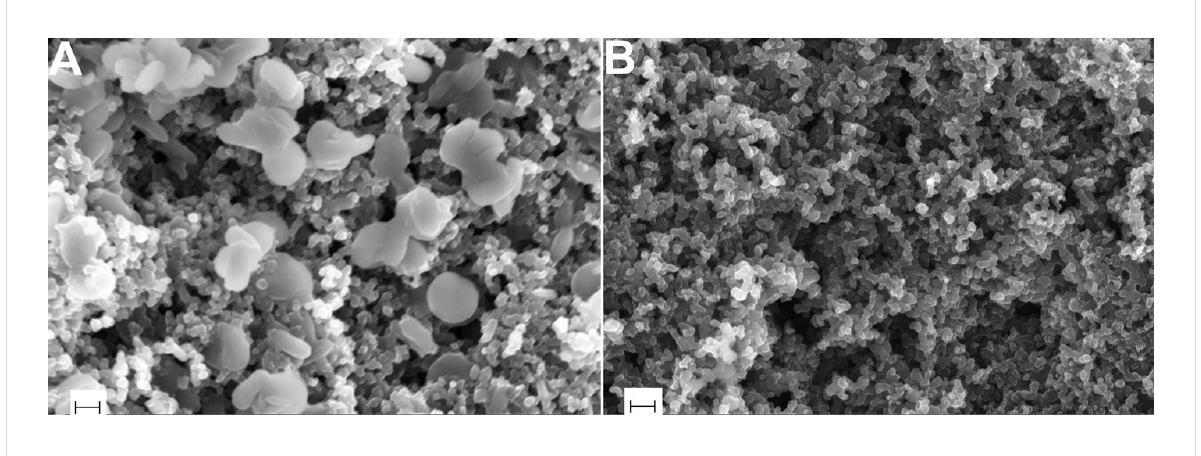
Figure 6: Microstructures of (A) discharged and (B) recharged electrodes. The formation of lithium peroxide crystals on the discharged electrode up to 1000 mAh·(g carbon) − 1 is clearly visible in (A). The scale bars correspond to 200 nm.